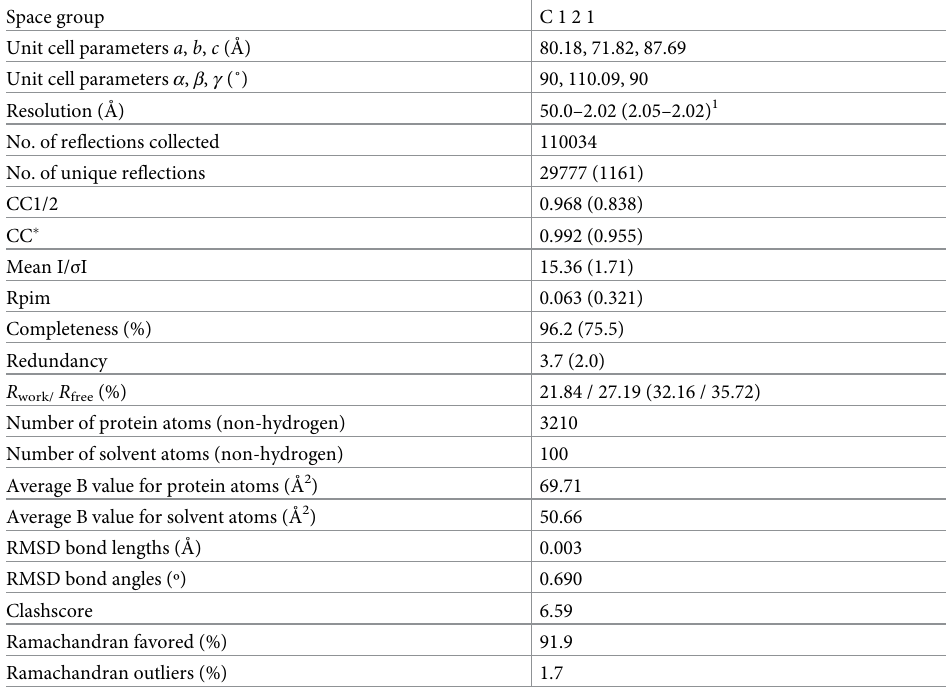
Table 1. Crystallographic data collection and model refinement